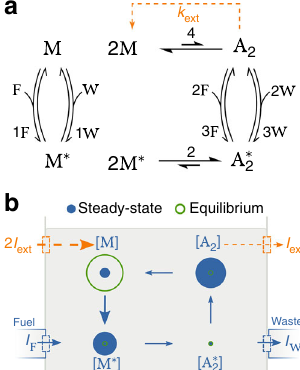
Fig. 1 Model for energy storage and driven synthesis. Without (resp. with) the orange dashed transition, the chemical reaction network models energy storage (resp. driven synthesis). The high-energy species A 2 is at low concentration at equilibrium. Powering the system by chemostatting fuel ( F ) and waste ( W ) species boosts the formation of A 2 out of the monomer M via the activated species M 2 and A (cid:3) 2 . a The chemical reaction network (forward fl uxes are de fi ned counter-clockwise). b Sketch of concentrations distributions (proportional to radii) and net currents (proportional to arrows thickness, see Supplementary Note